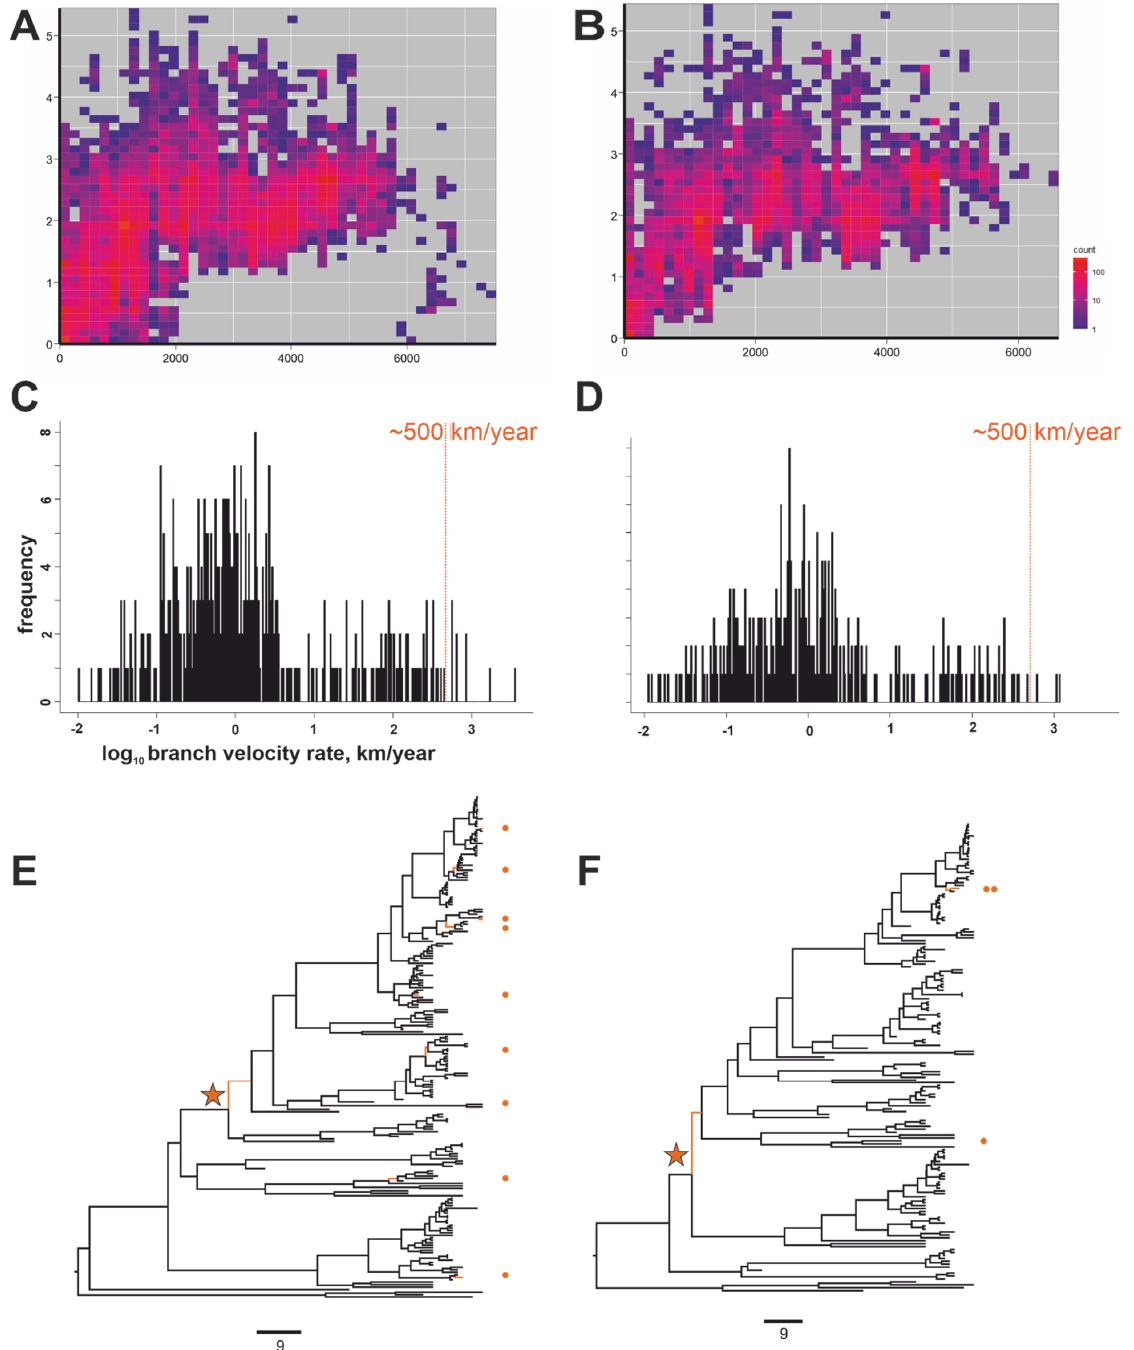
Figure 4. ( A ) Gene-geo plot for the steppe RABV group ( n = 205). ( B ) Gene-geo plot for the steppe RABV group without sequences that were identical in more than 99.7% of nucleotides and whose collection sites were separated by at least 500 km were removed from the corresponding alignments ( n = 161). ( C , D ) The distribution of velocity rates in the branches of MCC (maximum clade credibility) phylogenetic trees ( E , F ) in log-scale for all steppe RABV group sequences (( C ) n = 205) and excluding sequences with a putative long-distance transfer history (( D ) n = 161). The orange line indicates a velocity rate of 500 km/year. ( E , F ) MCC phylogenetic trees for all steppe RABV group sequences (( E ) n = 205) and after omitting sequences with a putative long-distance transfer history (( F ) n = 161). Branches with velocity rates over 500 km/year are colored orange and marked with orange circles. The star indicates a transfer from the South Urals region to the east, as discussed in the text.